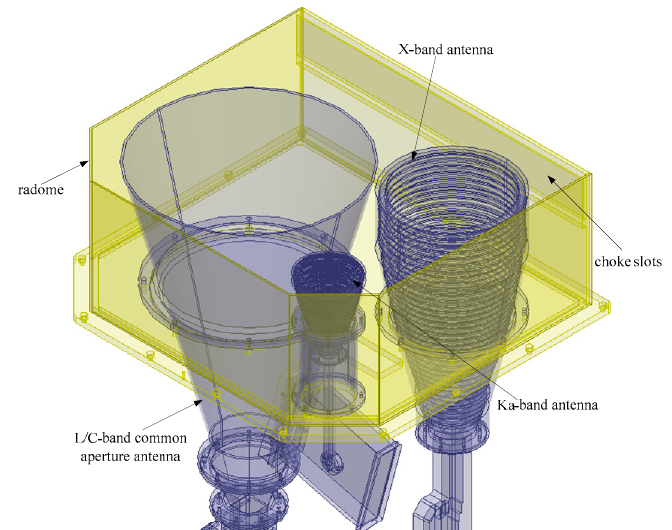
Figure 2. Schematic illustration of the combined antenna.